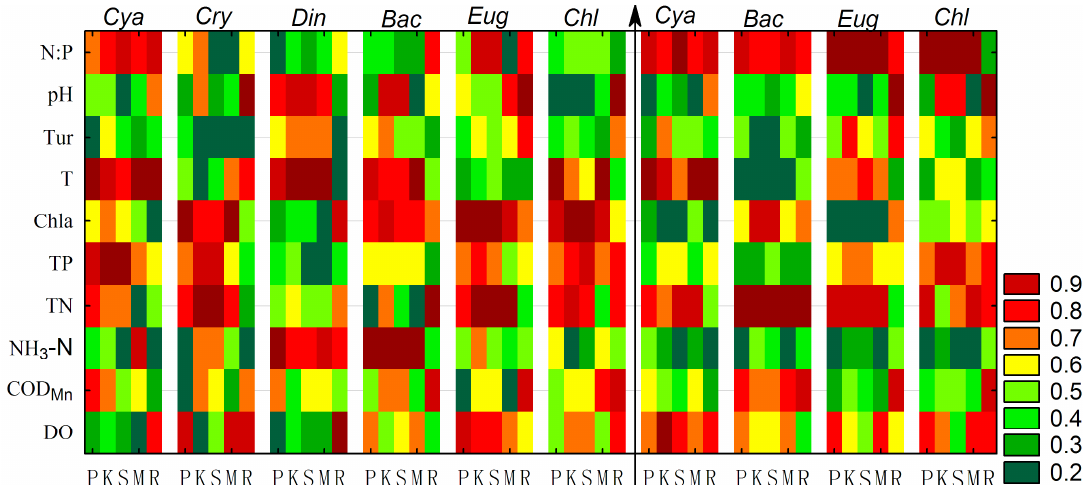
Figure 6. Identification of environmental factors affecting the distribution of planktic algae (left) and epipelic algae (right). P, K, and S: the correlation analysis of Pearson, Kendall, and Spearman; M: multiple stepwise regression analysis; R: Redundancy analysis; T: temperature; Tur: turbidity; N:P: ratio of nitrogen and phosphorous. Cya : Cyanobacteria; Cryptophyta (Cry); Din : Dinophyta; Bac : Bacillariophyceae; Eug : Euglenozoa; Chl : Chlorophyta. The color change from green to red shows the increase of importance on the effect of algae distribution. For the calculation method see Section 2.4.